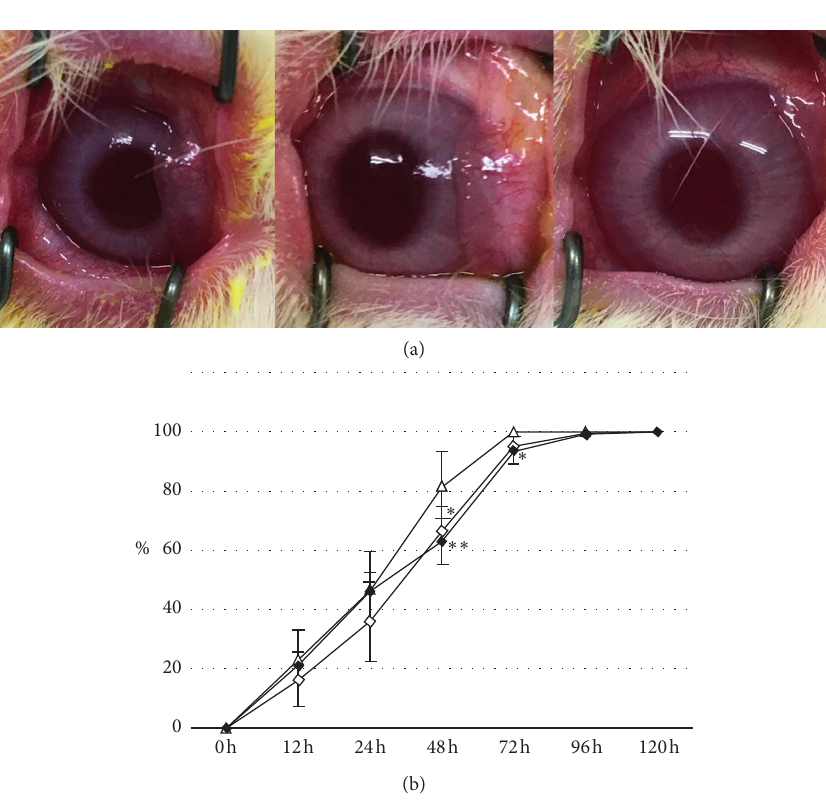
Figure 3: Corneal wound healing of eyes treated with D-PRP and T-PRP. (a) Representative clinical findings of the cornea after treatment with control (A), D-PRP (B), and T-PRP (C). (b) Comparison of wound healing rate between PRP treatment and control. Opened triangle, control; opened rhombuses, D-PRP; closed rhombuses, T-PRP. ∗ P < 0.05 and ∗∗ P < 0.01. Data represent mean ± standard deviation (SD) ( n �